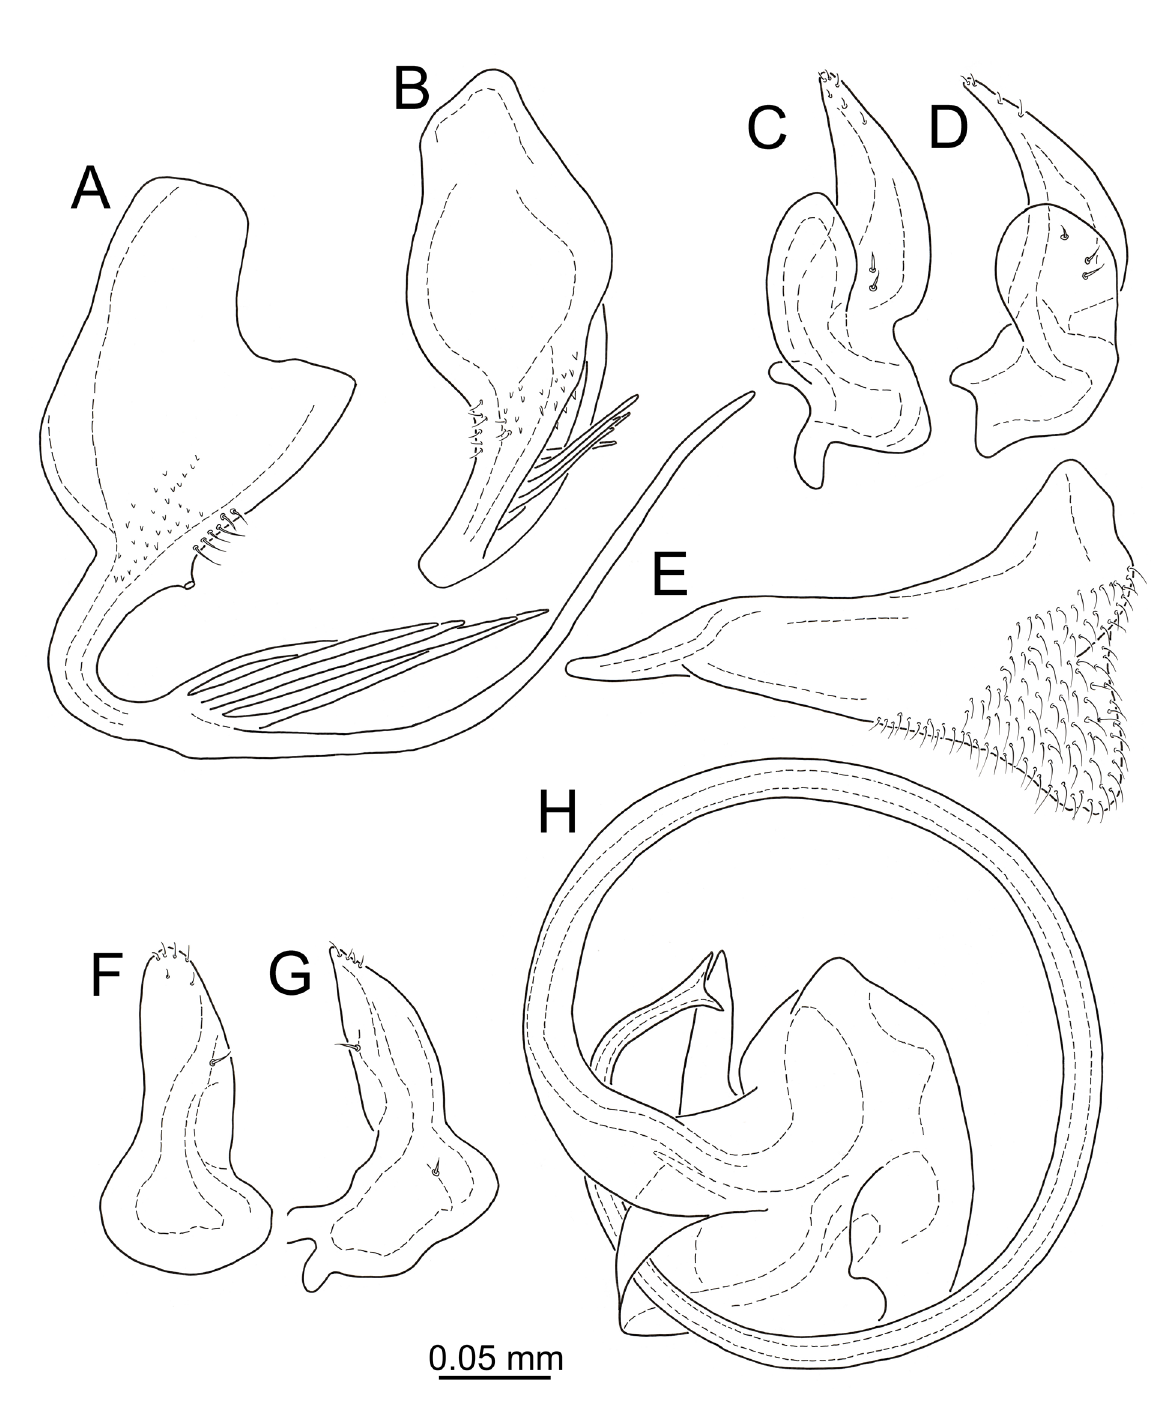
Fig. 14. Kokeshia hsiaoi Ren & Zheng, 1992, segment VIII and genitalia, ♂ (SYSBM). A‒B . Left hemitergite VIII. A . Dorsal view. B . Left lateral view. C‒D . Left paramere, two different aspects. E . Right hemitergite VIII, dorsal view. F‒G . Right paramere, two different aspects. H .